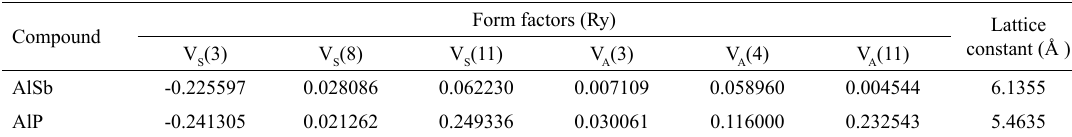
Table 2. Pseudopotential parameters for AlSb and AlP.